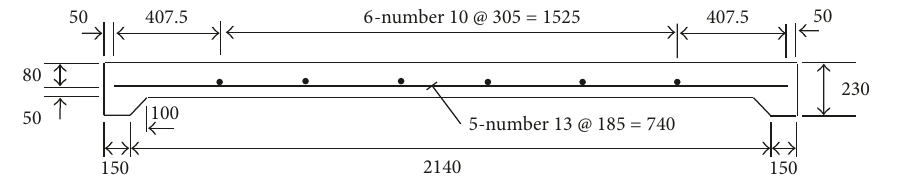
Figure 3: Reinforcement details for the control slab specimen having the width of 900 mm.